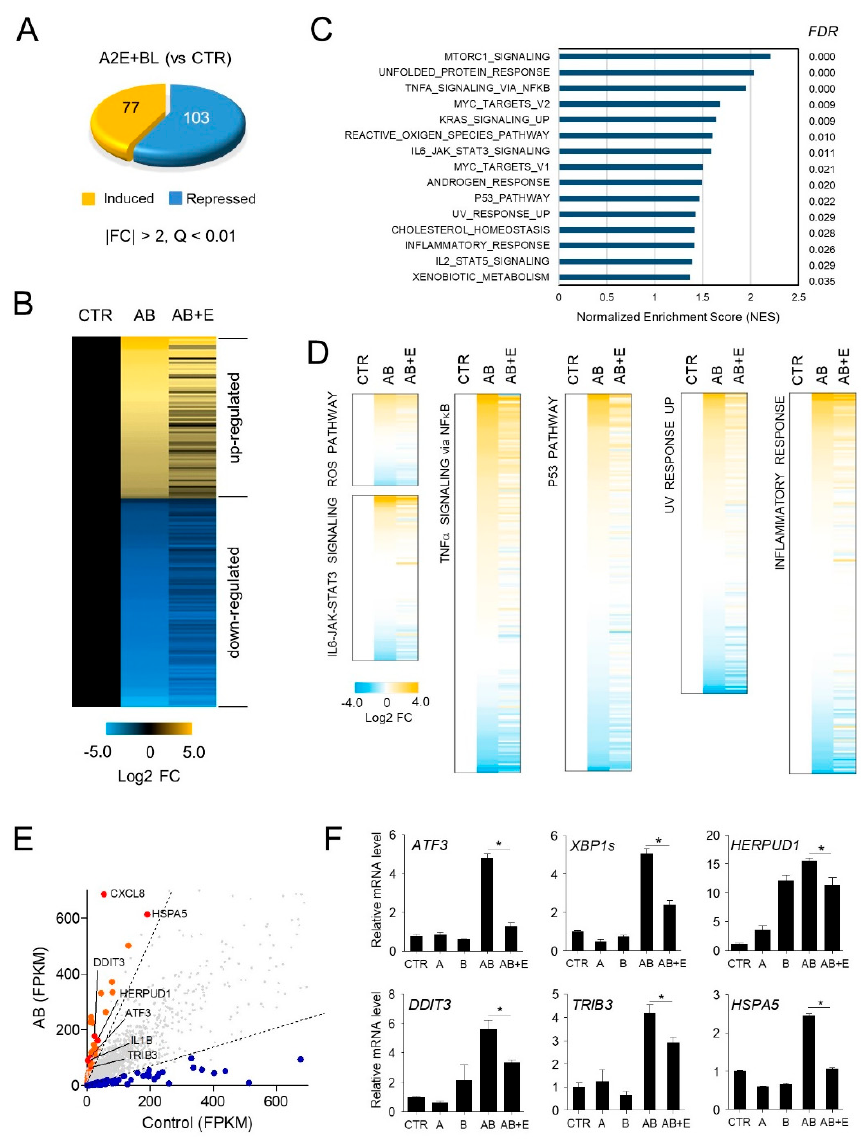
Figure 4. Effect of EPX on genome-wide gene expression in ARPE-19 cells. ( A ) Differentially expressed genes by A2E and BL in ARPE-19 cells. A2E-laden ARPE-19 cells were exposed to blue light (BL), as shown in Figure 2A. RNA-seq analysis showed differentially expressed genes (DEGs) after BL exposure in A2E-laden RPE cells (A2E + BL) compared to untreated cells (CTR). FC—fold change; A2E—Bis-retinoid N-retinylidene-N-retinylethanolamine; BL—blue light. ( B ) Heatmap generated from three groups, including A2E-free ARPE-19 cells (CTR) and BL-stimulated A2E-laden RPE cells, in the absence (AB) and presence of EPX (AB + E). Values represent the log2 fold-